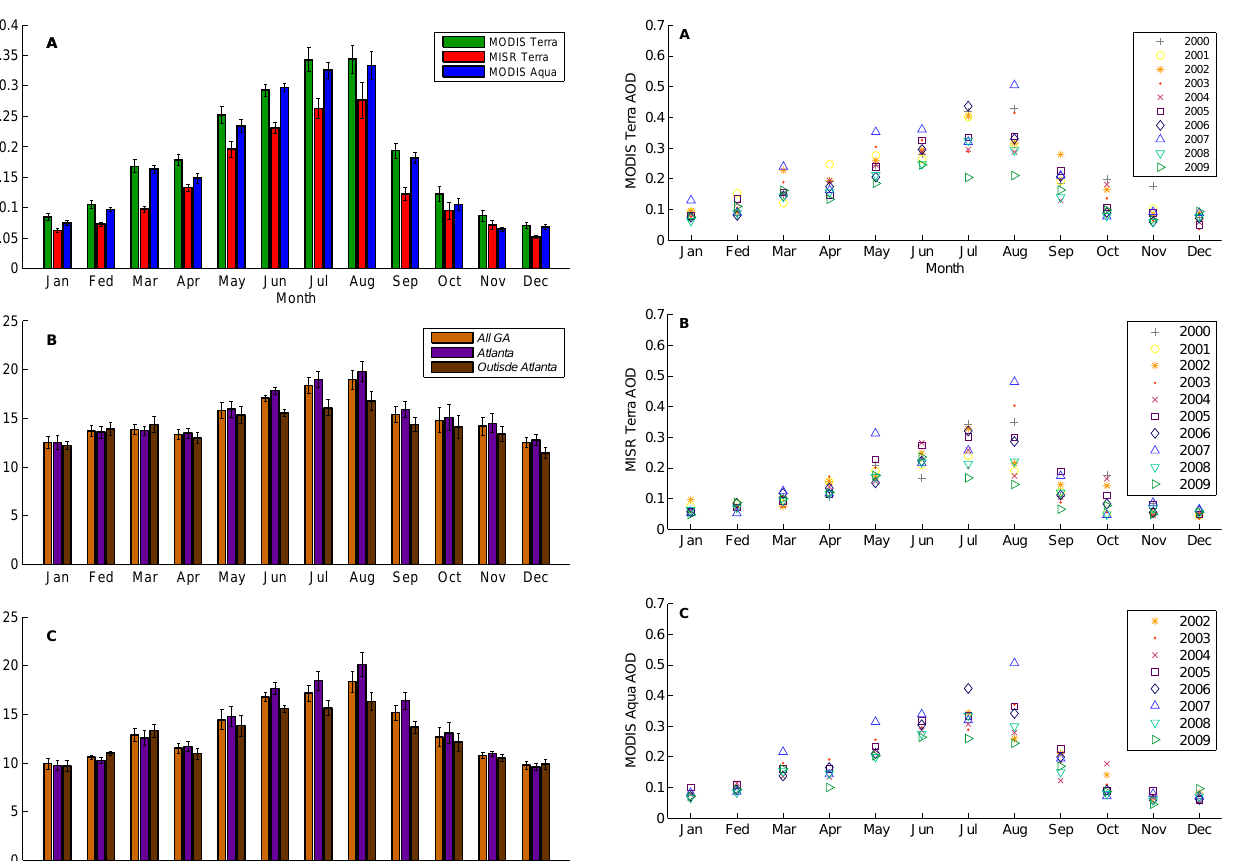
Fig. 3a. (A–C) Multi-year plots of monthly means for MODIS Terra AOD, MISR Terra AOD, and MODIS Aqua AOD. more increase in surface concentrations that are not observed elsewhere in the